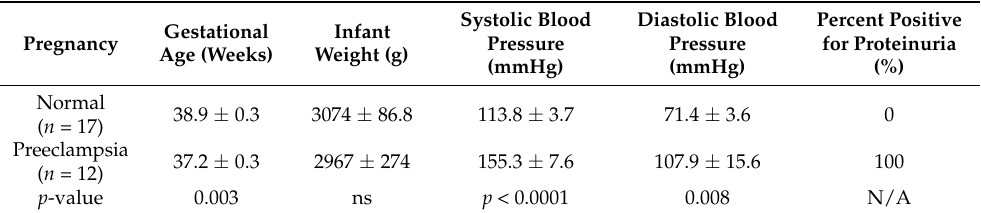
Table 1. Clinical Characteristics of Pregnancies. Samples were analyzed with a Student’s t -test or Mann–Whitney test when non-parametric (Mean ±